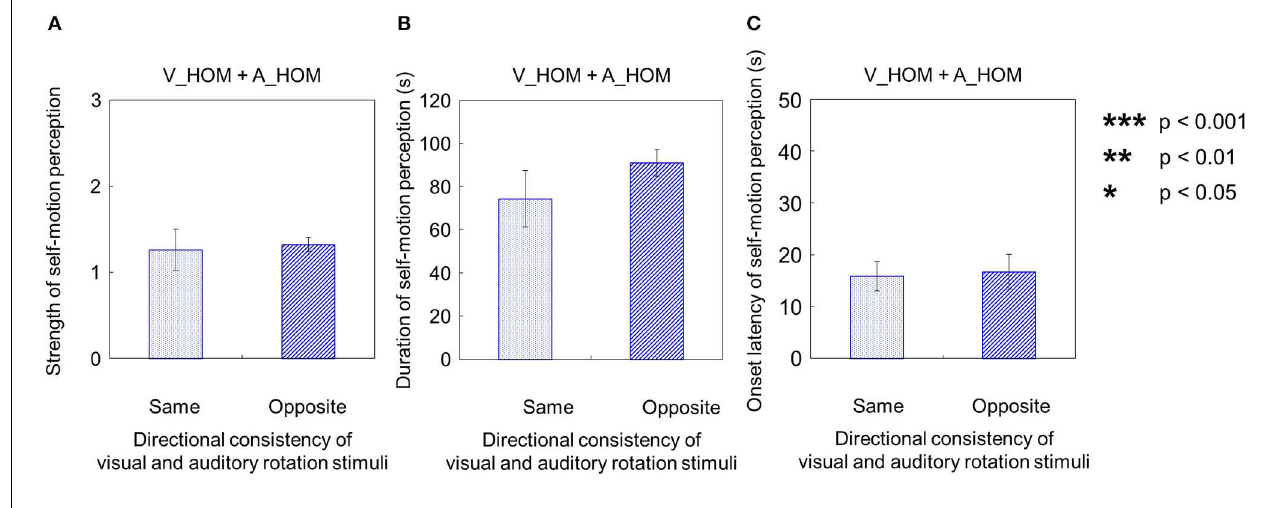
FIGURE 12 | Averaged values of the (A) strength, (B) duration, and (C) onset latency of self-motion perception in the condition combining visual horizontal one-directional motion (V_HOM) and auditory